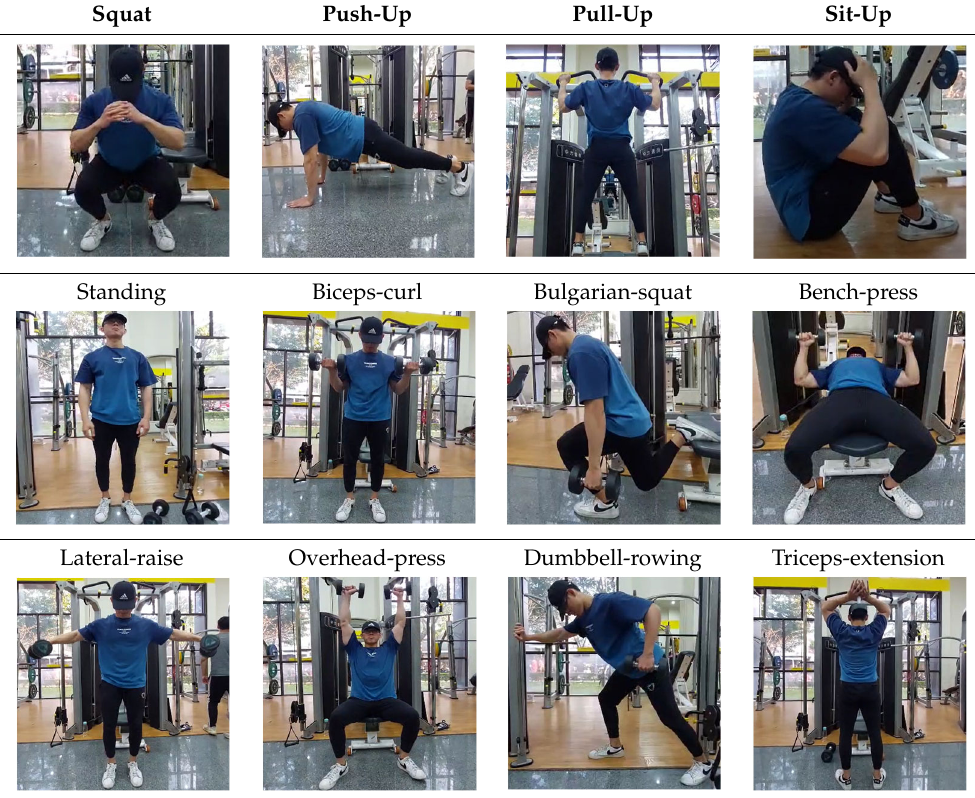
Table 1. Twelve types of fitness movements and names.